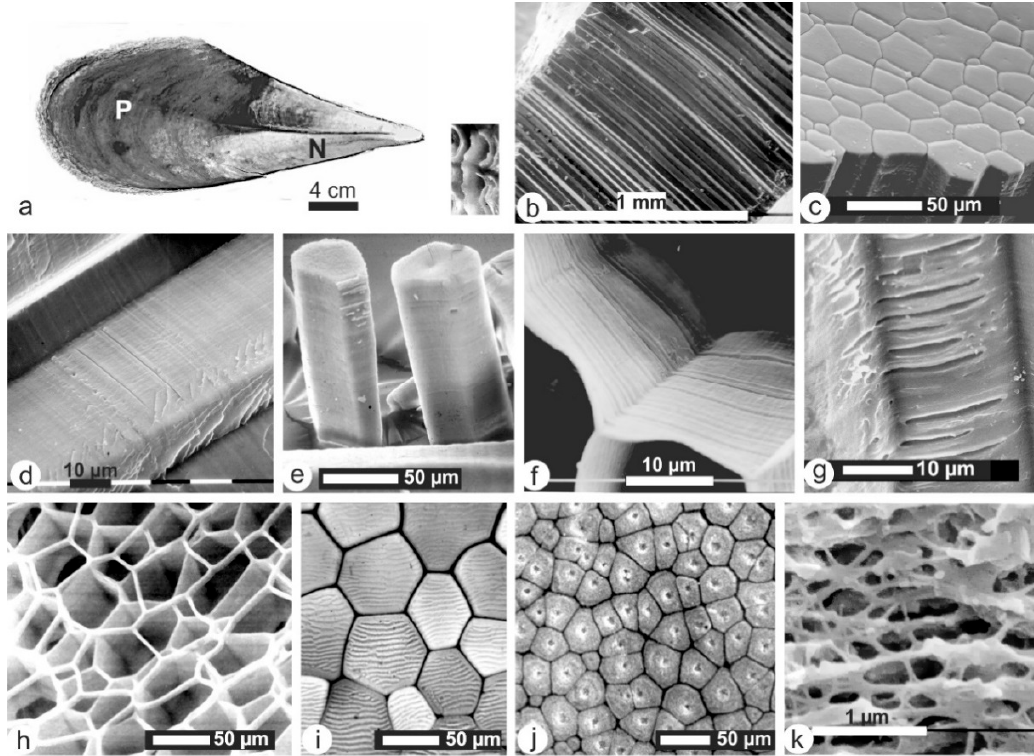
Figure 2. Microstructure of the prismatic layer of Pinna . ( a ) Inner surface of P. nobilis , showing the nacreous (N) and prismatic (P) layers, and corrugated appearance due to the presence of undulating lamella on the outer surface (insert). ( b ) Vertical fracture showing the straight parallel prismatic units. ( c ) Inner surface of the shell showing the polygonal shape of the prisms; compare with Figure 1a. ( d ) Fracture showing faint growth lines on the longitudinal faces of a prism. ( e ) Isolated prisms; compare with Figure 1d. ( f ) Detail of the surface of inter-prismatic membranes, showing thin parallel growth layers. ( g ) The inter-prismatic membrane is partially dissolved using an organic solvent (chloroform). ( h ) Decalcified prismatic layer showing that the inter-prismatic organic membranes have a layered arrangement, after one week in Milli-Q water. ( i ) Growing surface showing crests and grooves; compare with Figure 1c. ( j ) Surface of a growth lamella showing “centres” of calcification. ( k ) Polished, fixed and decalcified sections showing the organic framework within a prism. Fixation: glutaraldehyde 6% buffered with Na cacodylate (0.4 M) and NaCl (7%); etched by RDO Rapid Decalcifier (Apex Engineering Products, Aurora, CO, USA) for 15 s, washed with Milli-Q water and dehydrated using alcoholic solutions from 30% to 100%.